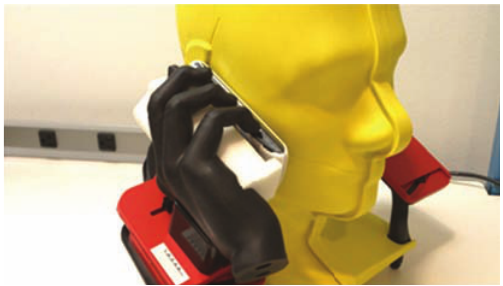
F 5: Over-the-air phone testing in the talk position, including the phantom